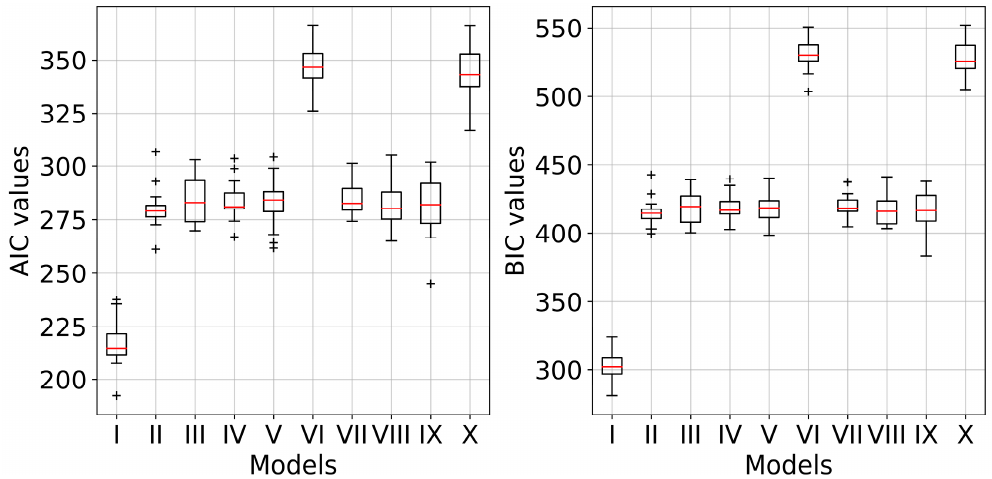
Figure 5. Box ‐ plot of the Akaike Information Criteria (AIC) and Bayesian Information Criteria (BIC) values obtained by using the ten models (validation datasets) for all the sites studied. On each box: the red central mark=median; bottom and top edges of the box = 25th and 75th percentiles, respectively; whiskers extend to the most extreme values are not considered outliers (‘+’ symbol). In terms of the statistics R, RMSE, MAPE and NSE, the mean, maximum and minimum values obtained in the sixteen locations are summarized in Table 4 for each model and dataset studied.